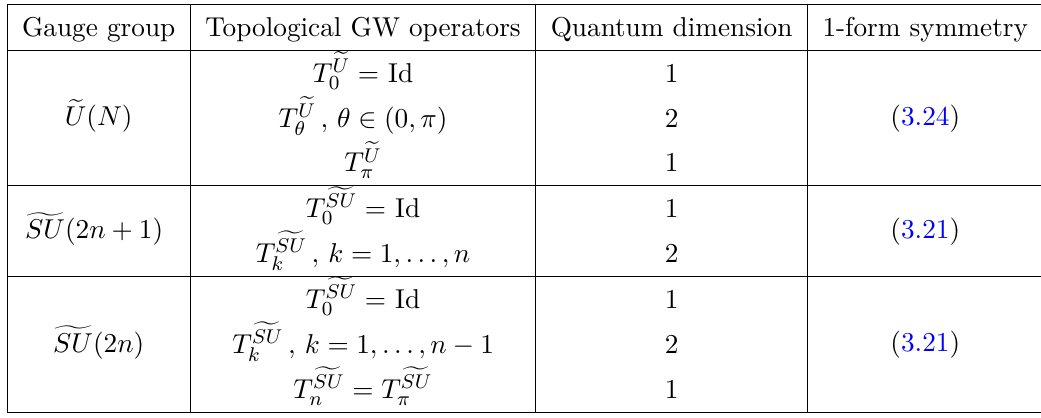
Table 3 . Summary of topological Gukov-Witten operators for theories with e U ( N ) and g SU ( N ) gauge